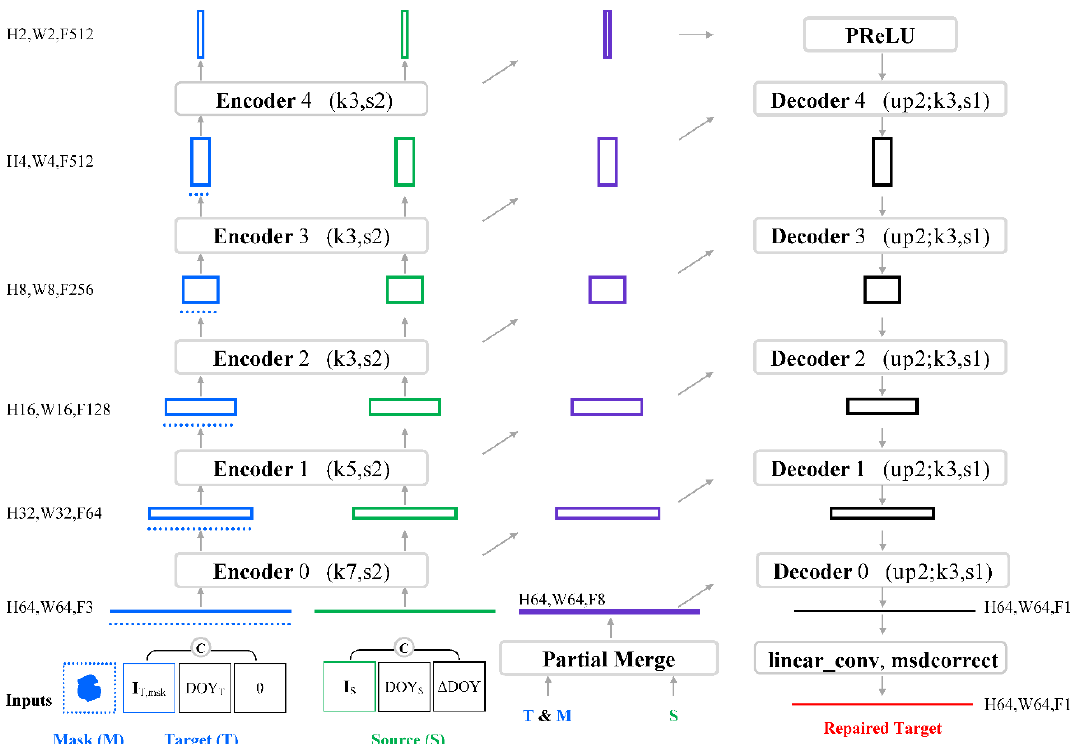
Figure 1. The overall architecture of the proposed Source Augmented Partial Convolution v2 (SAPC2) model. The colors and shapes denote the origin and / or the purpose of the symbols. The grey boxes / circles indicate operators (including custom layers). The arrows show the data flow of SAPC2; the horizontal lines and non-grey rectangles indicate data. The blue rectangles highlight data on the target path. Similarly, the green, purple, and black rectangles are data associated with the source path, the skip connection, and the decoder path, respectively, and the red line highlights the model output (i.e., the raw repaired target image). The dotted lines are masks and imply the associated image has missing pixels. The spatial size and number of features are either labeled near the data symbols or placed on the left side of the figure.